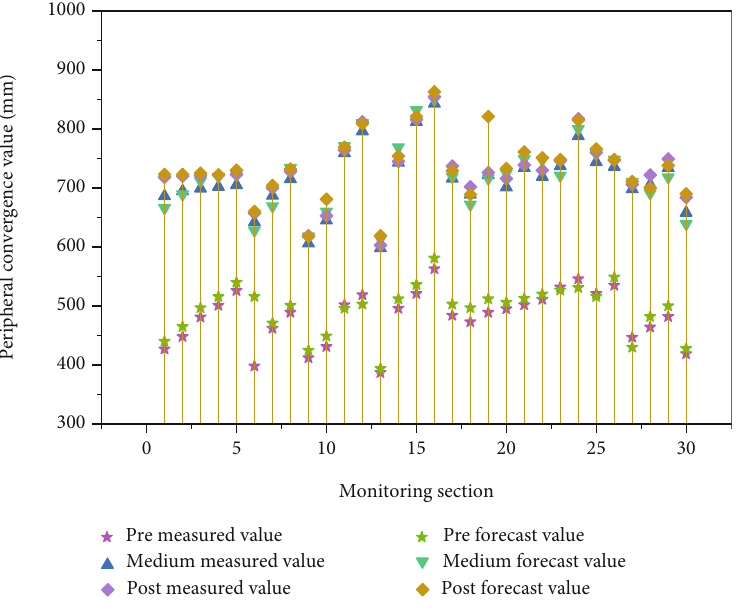
Figure 12: Prediction results of convergence around the tunnel.